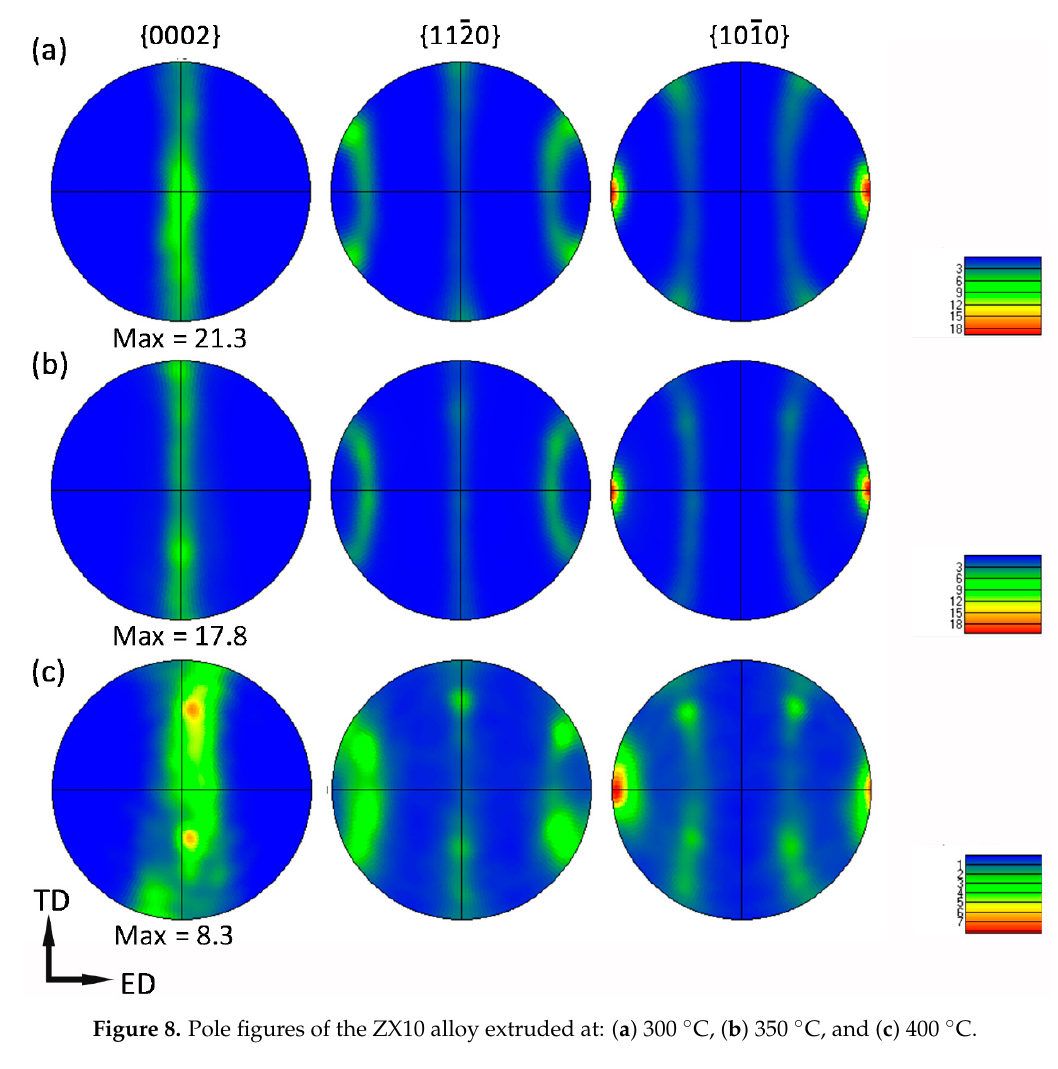
Figure 8. Pole figures of the ZX10 alloy extruded at: ( a ) 300 °C, ( b ) 350 °C, and ( c ) 400 °C.